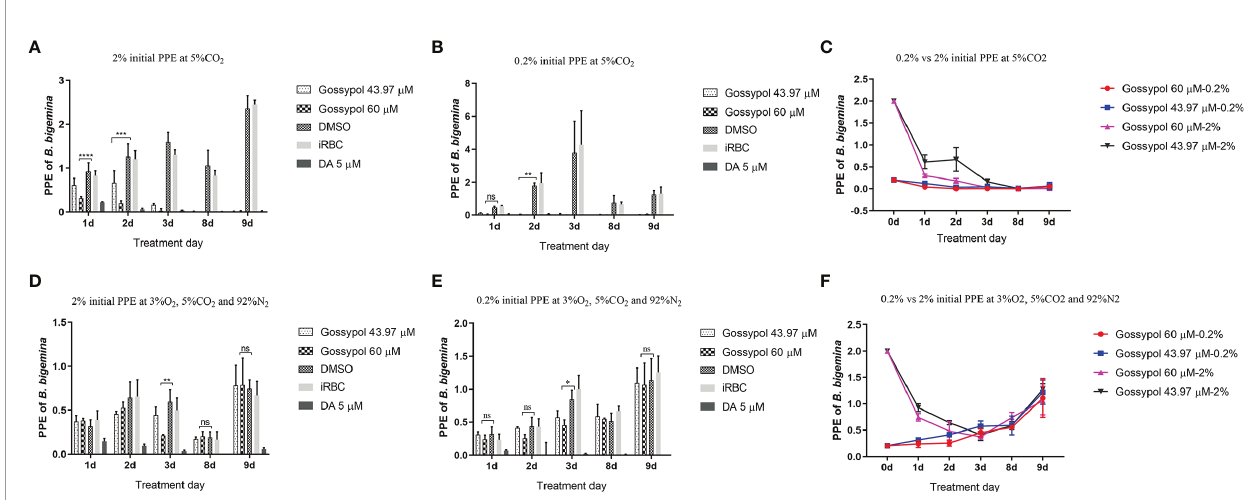
FIGURE 5 | B. bigemina cultured with IC 50 or IC 98 gossypol in low oxygen (3% O 2 , 92% N 2 , and 5% CO 2 ) or ambient oxygen (5% CO 2 ) incubators. (A) B. bigemina cultured at ambient oxygen with 2% initial PPE; (B) B. bigemina cultured at ambient oxygen with 0.2% initial PPE; (C) Comparing B. bigemina cultured at ambient oxygen with 2% and 0.2% initial PPE. (D) B. bigemina cultured at low oxygen with 2% initial PPE; (E) B. bigemina cultured at low oxygen with 0.2% initial PPE; (F) : Comparing B. bigemina cultured at low oxygen with 2% and 0.2% initial PPE. Data were analyzed by using Graphpad Prism7 with two-way ANOVA. ns represents no difference; *p < 0.0332, **p < 0.0021, ***p < 0.0002, ****p < 0.0001.